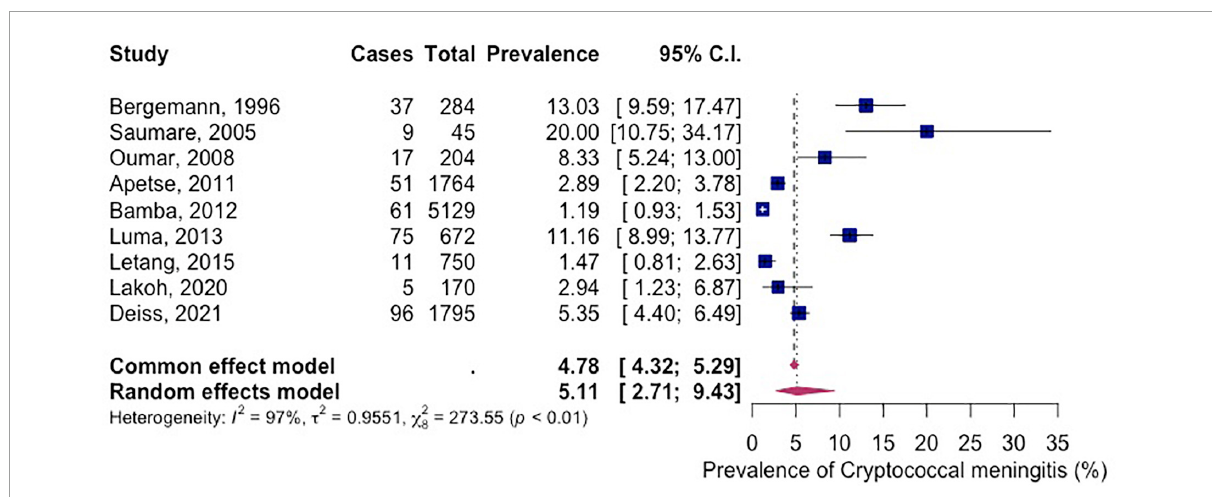
FIGURE3 Forest plot of prevalence of HIV related cryptococcal meningitis in Africa (random effects),